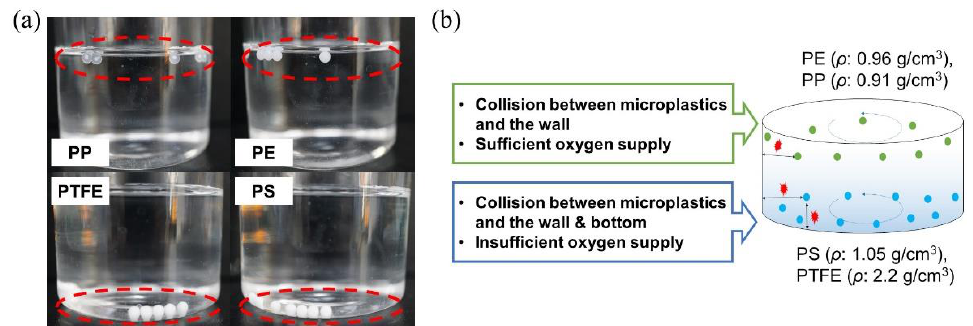
Figure 3. ( a ) Images of microplastics in water. ( b ) The possible mechanism of biofilm detachment from the microplastic surface.